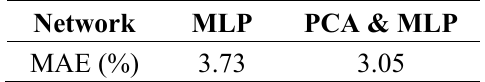
Table 4. MAEs of best-performed MLPs with and without PCA technique. Network